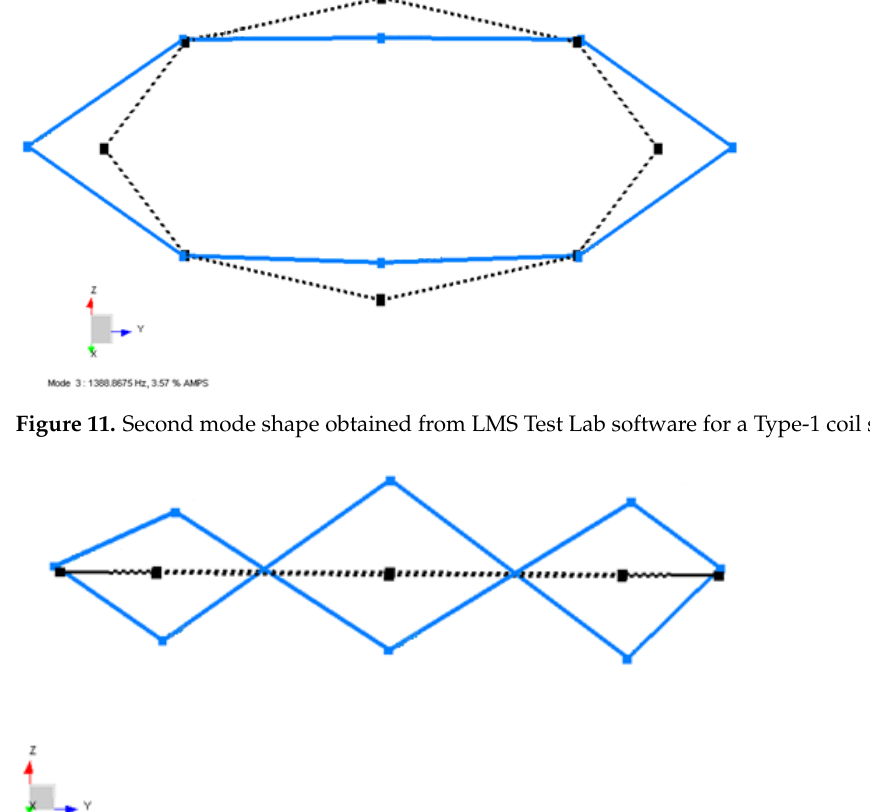
Figure 12. Third mode shape obtained from LMS Test Lab software for a Type-1 coil sample.